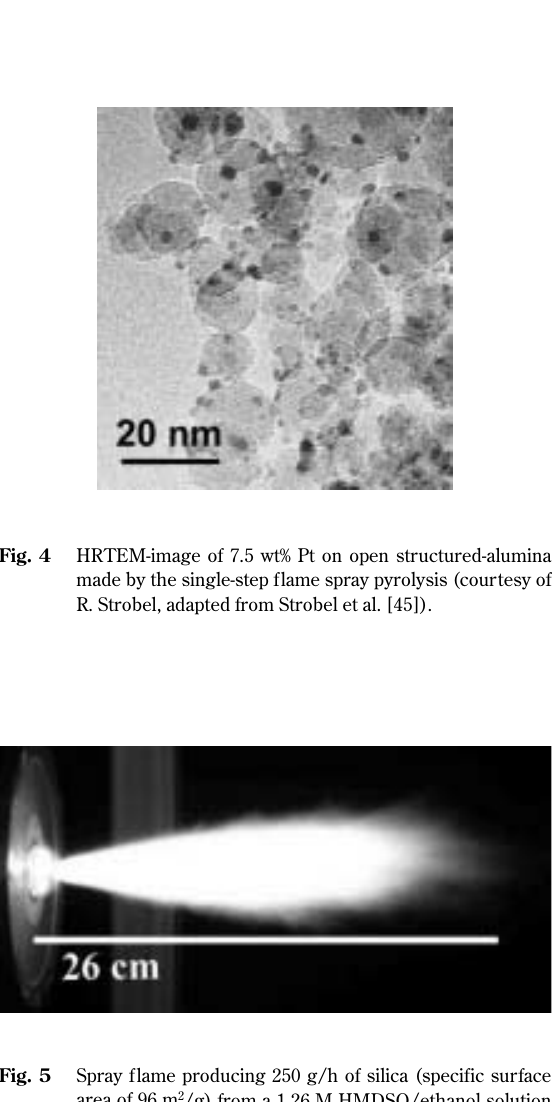
Fig. 5 Spray flame producing 250 g/h of silica (specific surface area of 96 m 2 /g) from a 1.26 M HMDSO/ethanol solution (courtesy of R. Mueller, adapted from Mueller et al. [99]).